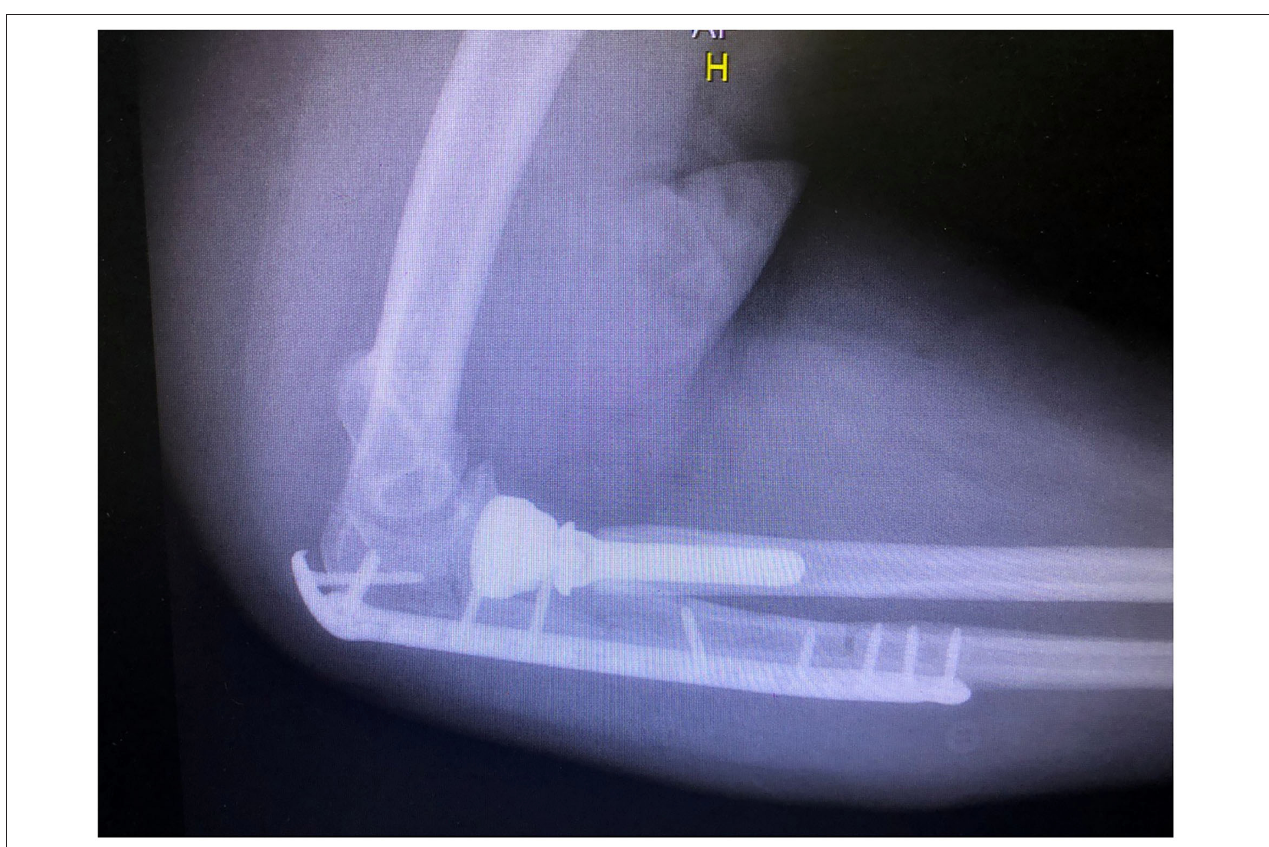
FIGURE 4 | Post-op lateral view (osteosynthesis of the ulna with proximally contoured locking plate and radial head